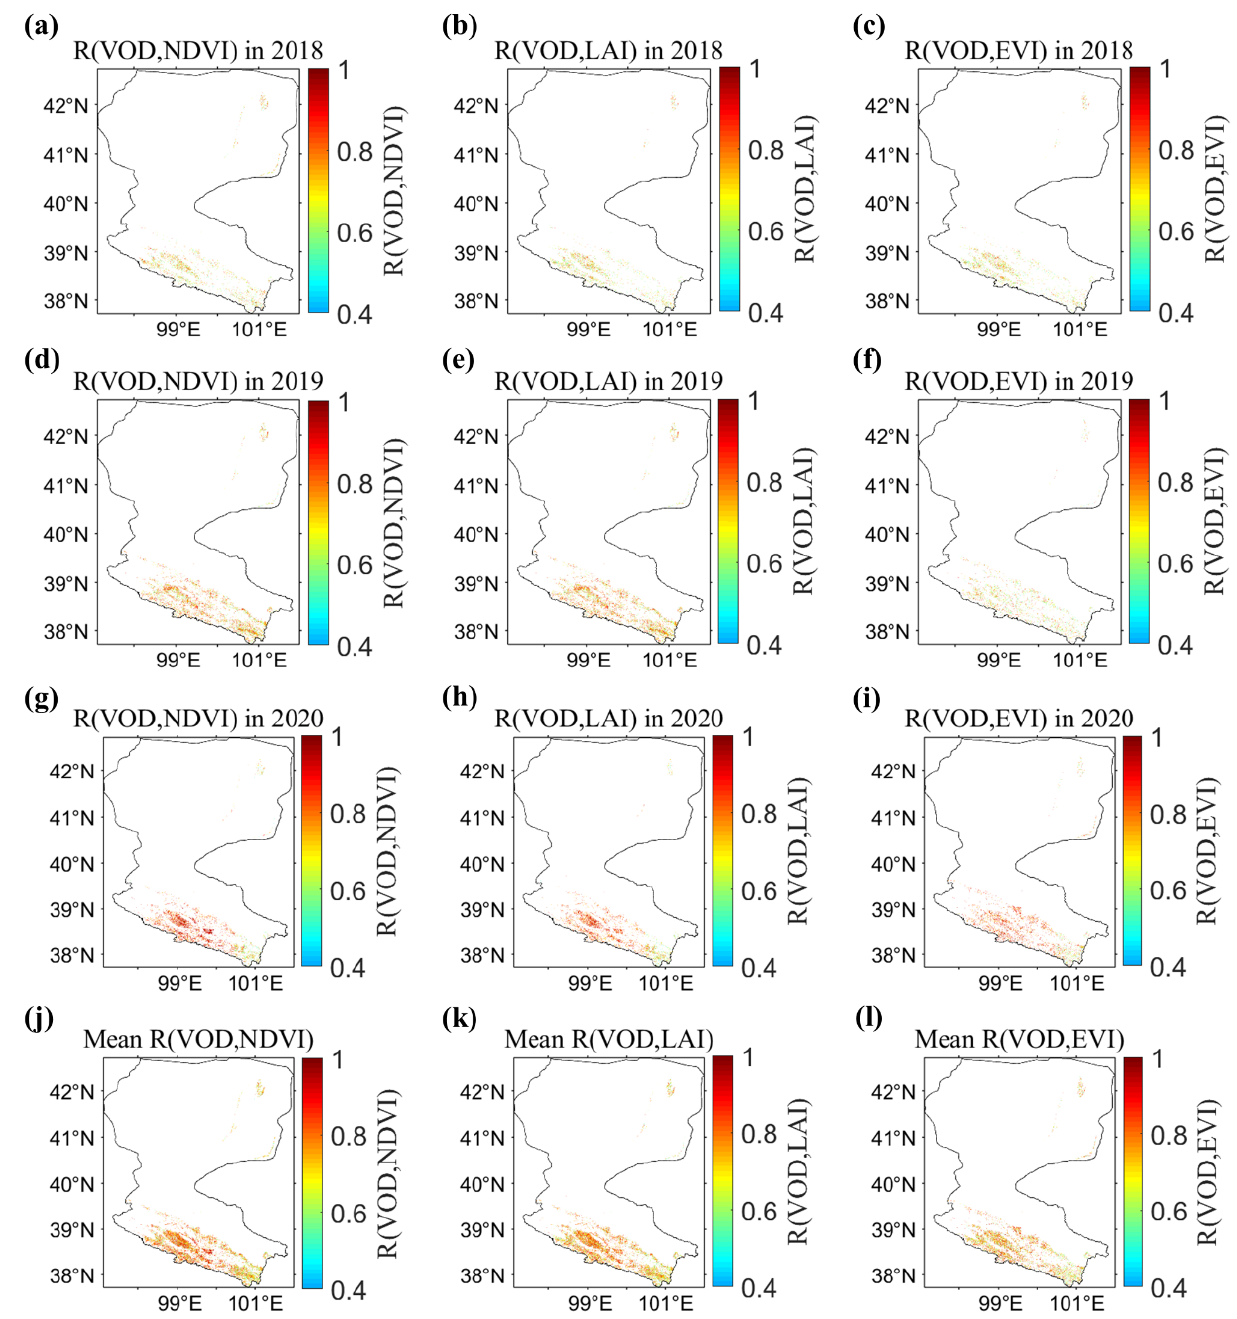
Figure 10. The correlation coefficient (R) between VOD (from top to bottom: VOD in 2018 ( a – c ), VOD in 2019 ( d – f ), VOD in 2020 ( g – i ), the three yearly average VOD ( j – l )) and three MODIS VIs (from left to right: NDVI, LAI, EVI).